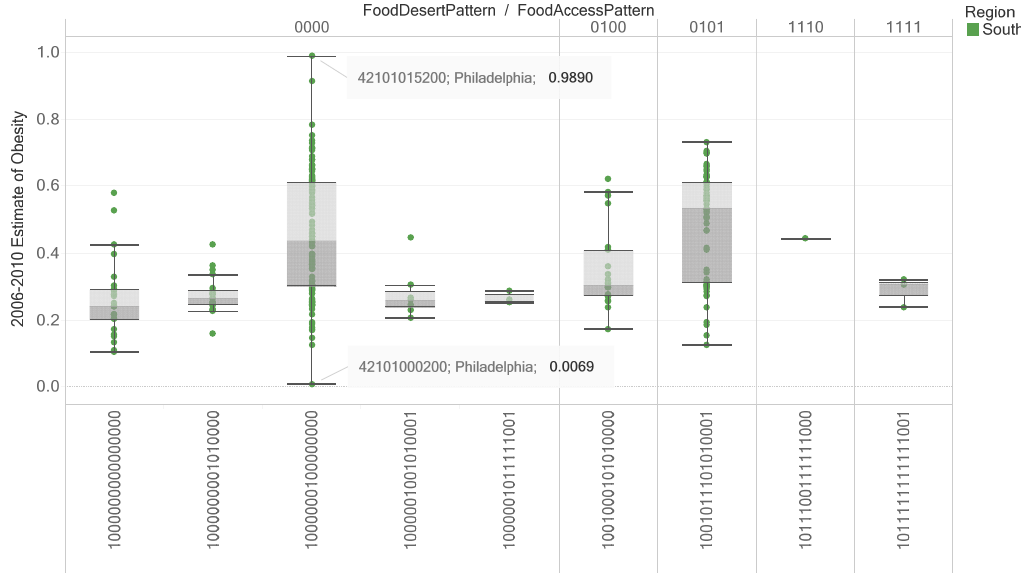
Figure 10. Regional comparison of estimates of obesity rates (2006–2010) for census tracts with the same food access pattern in Allegheny County, Southwest Pennsylvania. We designed the box plot to support decisions on differences in obesity rates in a county (attention and motivation functions of knowledge visualization). The design of the view allows one or more counties to be selected (elaboration function of the knowledge visualization).